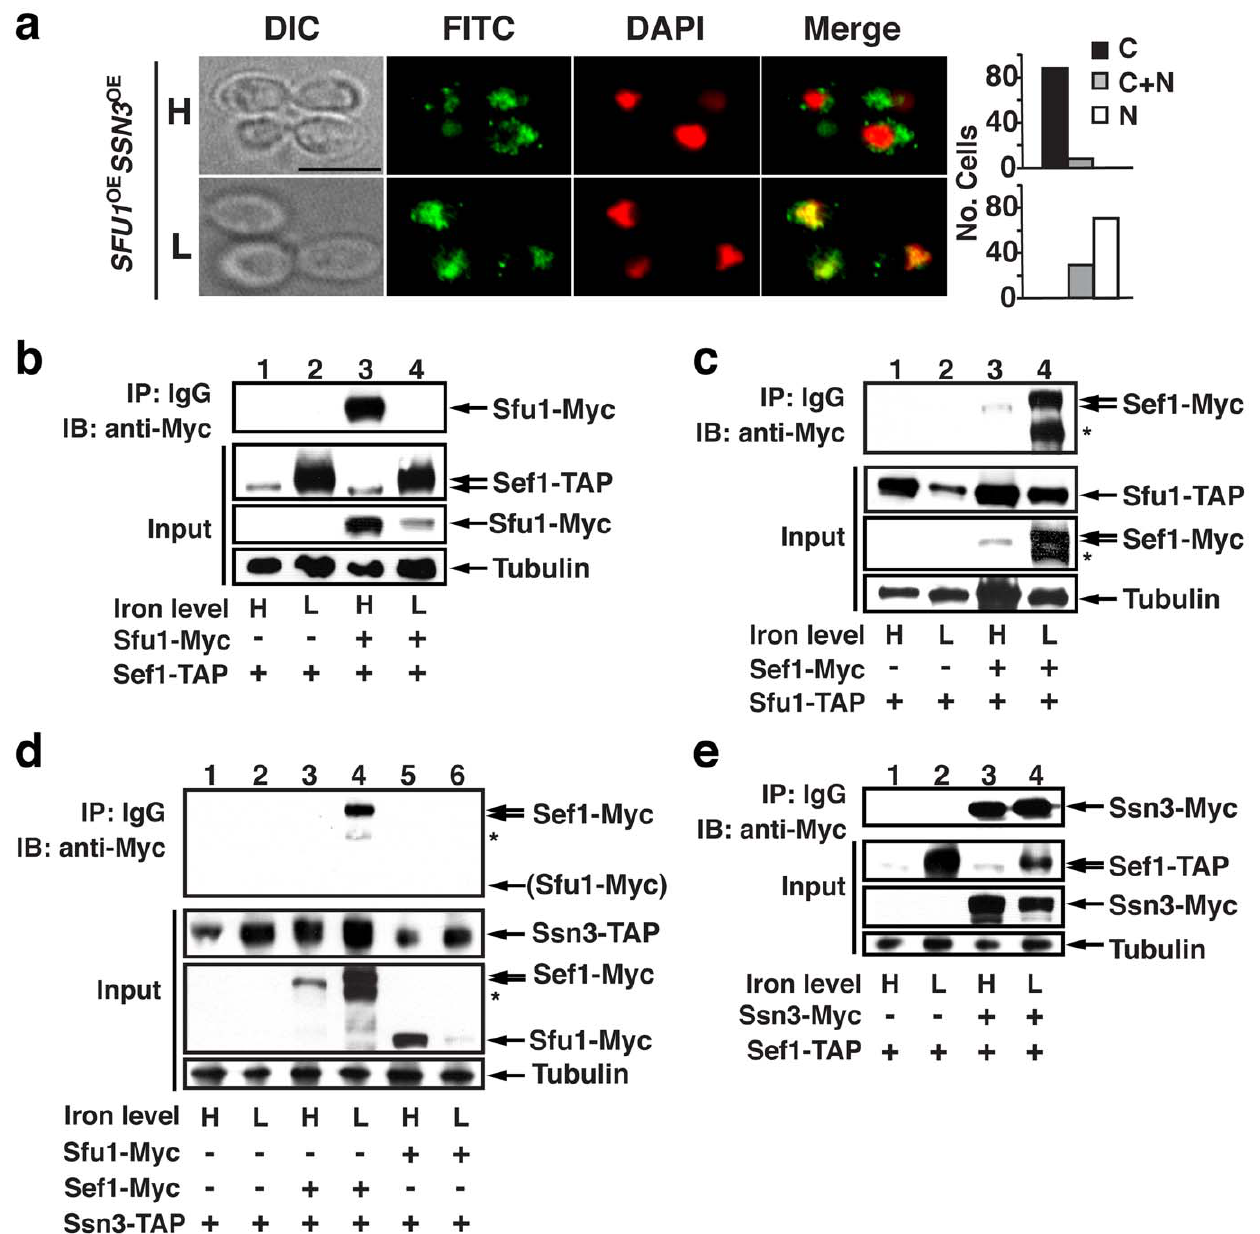
overexpresses both SFU1 and SSN3 , shown for cells cultured in iron-replete (H) and iron-depleted (L) conditions. Scale bar, 5 m m; all images obtained at the same magnification. b) Sfu1-Myc is co-immunoprecipitated with Sef1-TAP. Wild-type strains containing only Sef1-TAP or both Sef1-TAP and Sfu1-Myc were grown under iron-replete or iron-depleted conditions. Whole cell extracts were prepared under nondenaturing conditions, and IgG- sepharose was used to immunoprecipitate Sef1-TAP and associated proteins. Pellets were subjected to immunoblot analysis, using anti-Myc monoclonal antibodies to identify Sfu1-Myc. c) Sef1-Myc is co-immunoprecipitated with Sfu1-TAP. * indicates a presumed Sef1-Myc C-terminal proteolysis product that is observed only when Sef1 is recovered from nondenaturing extracts, such as those used for TAP purification. d) Sef1-Myc but not Sfu1-Myc is co-immunoprecipitated with Ssn3-TAP. e) Ssn3-Myc is co-immunoprecipitated with Sef1-TAP. * Presumed Sef1-Myc C-terminal proteolysis product, see